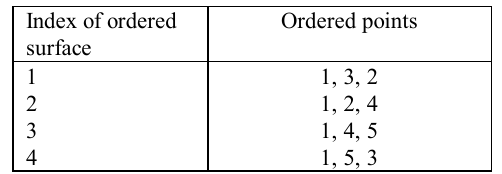
Table 8. Map structure with association of the index of the surface and the ordered indexes of the vertexes of this surface for Scenario 2.